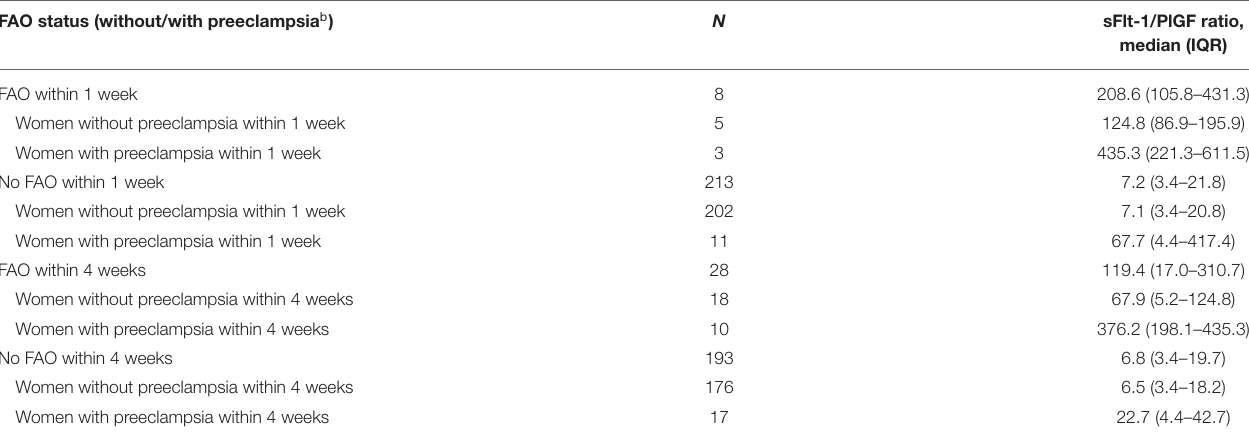
TABLE 3 | Distribution of sFlt-1/PlGF ratios by FAO status within 1 and 4 weeks in all women and by preeclampsia status. a FAO status (without/with preeclampsia b )